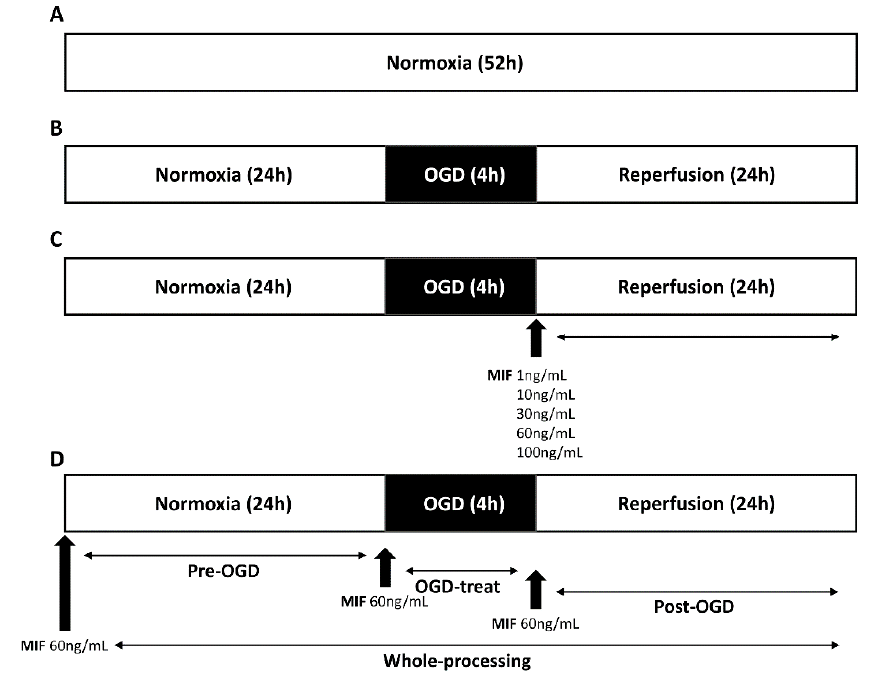
Figure 1. Schematic diagram of the study protocol. ( A ) Control group; ( B ) oxygen and glucose deprivation/reperfusion (OGD/R) group; ( C ) OGD/R group treated with different concentrations of macrophage migration inhibitory factor (MIF); ( D ) OGD/R group treated with MIF administered at different times.